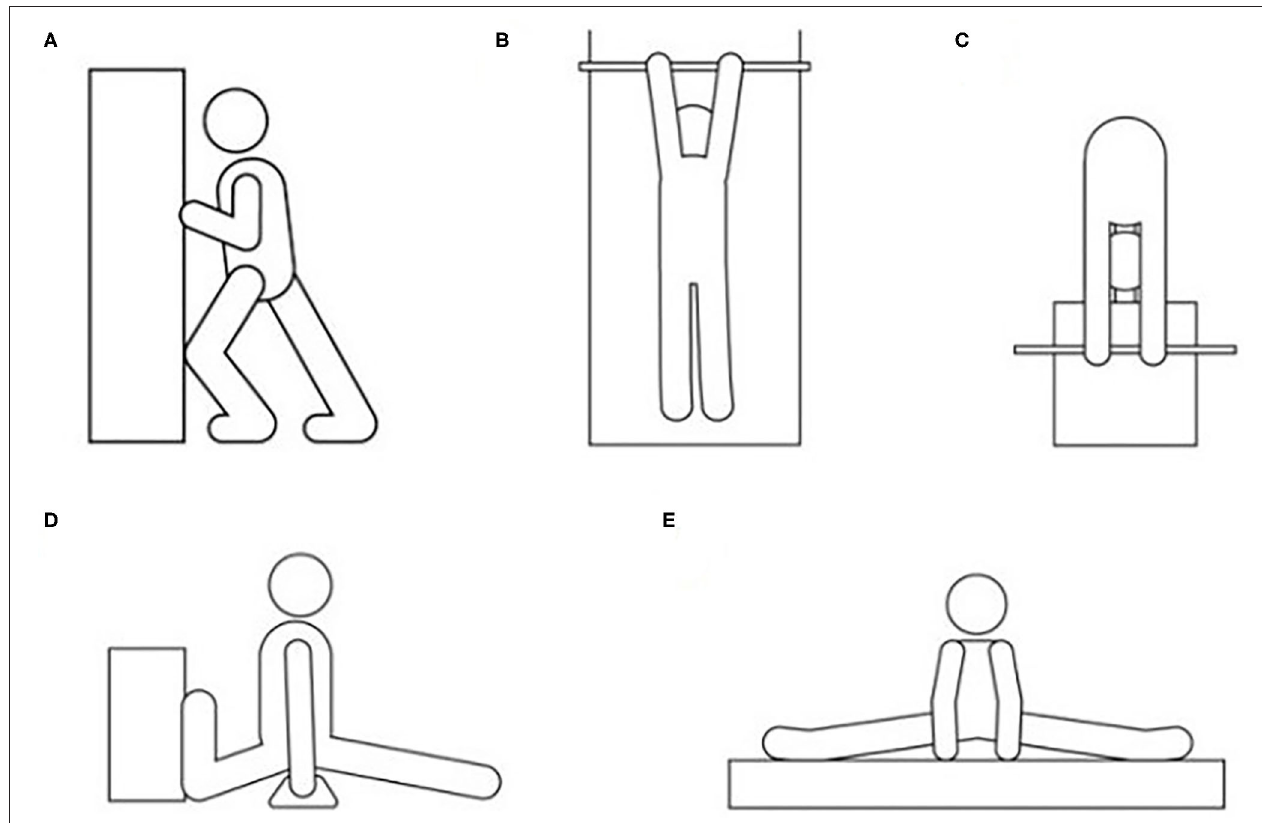
FIGURE 1 | The figure describes how the flexibility tests were performed with: (A) , the dorsiflexion lunge test for the right and left foot; (B) , the shoulder flexibility test; (C) , the trunk forward bending test; (D) , the front split test for the right and left legs; and (E) , the side split test.